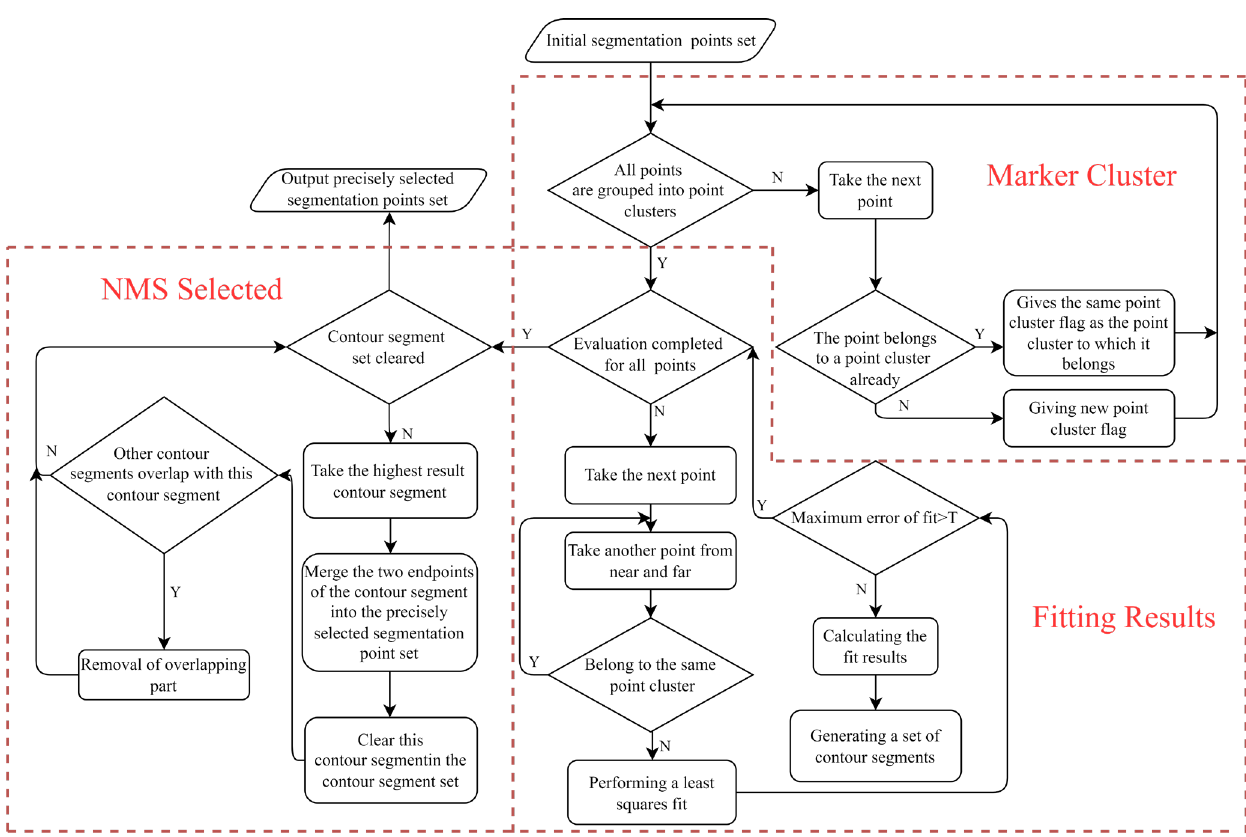
Figure 20. Flow chart of precise selection.